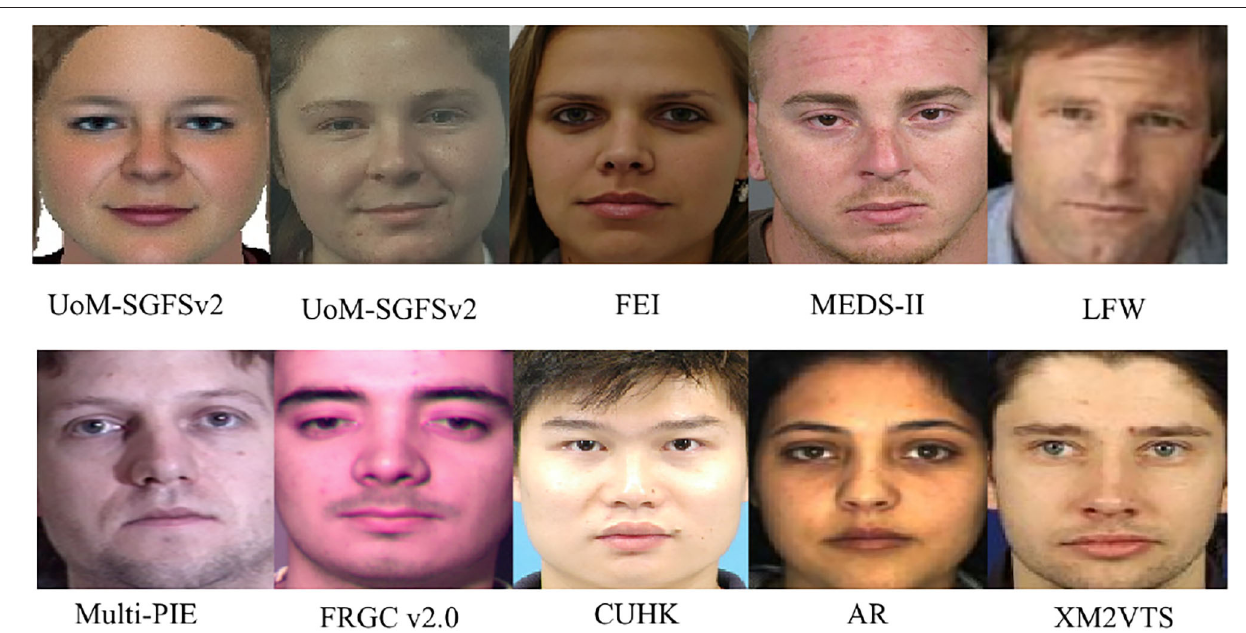
FIGURE 8 | Examples of cropped images in the following datasets: (top row) sketch in UoM-SGFSv2, photo in UoM-SGFSv2, FEI, MEDS-II, LFW , (last row) Multi-PIE, FRGC v2.0, CUHK, AR, and XM2VTS.